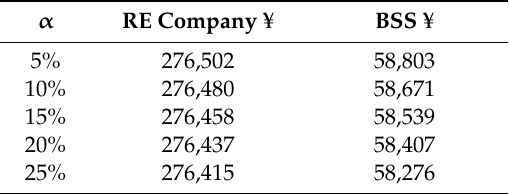
Table 4. The revenue of both sides with di ff erent α